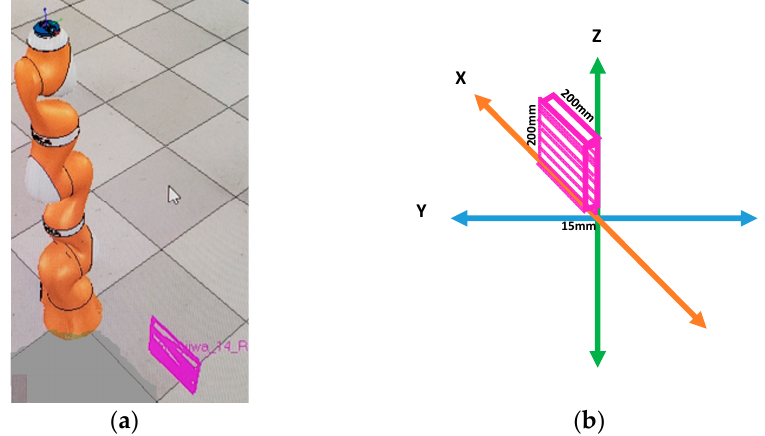
Figure 3. ( a ) Unwanted pHRI activities between a human participant and the Kuka robotic arm captured via V-Rep simulator, reproduced from [51], and ( b ) Cartesian representation of the 2D-XZ interactions in the 3D plane.